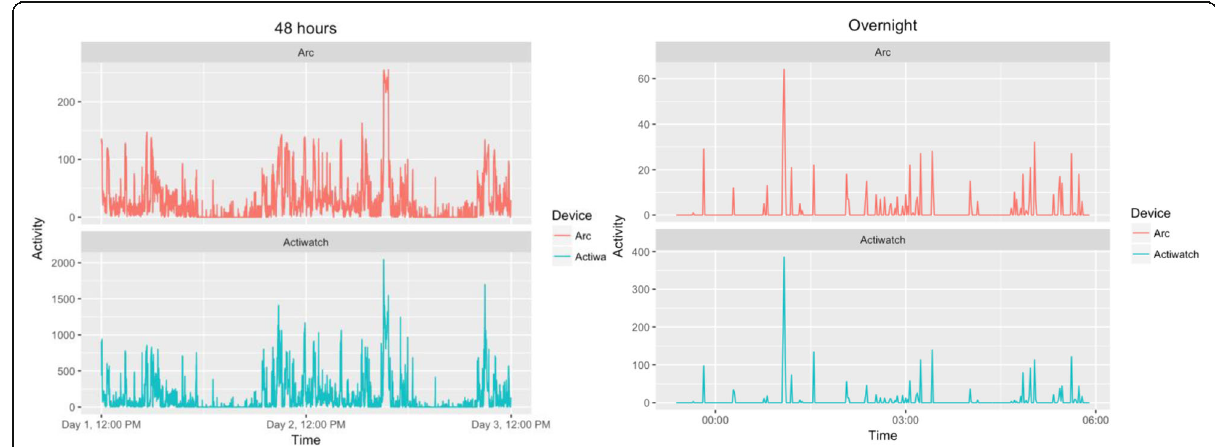
Fig. 1 (Left) Representative minute-by-minute activity tracing of Arc (top) and Actiwatch (bottom) from a participant over a ~ 48-h period. (Right) Representative minute-by-minute activity tracing of Arc (top) and Actiwatch (bottom) from a participant over one